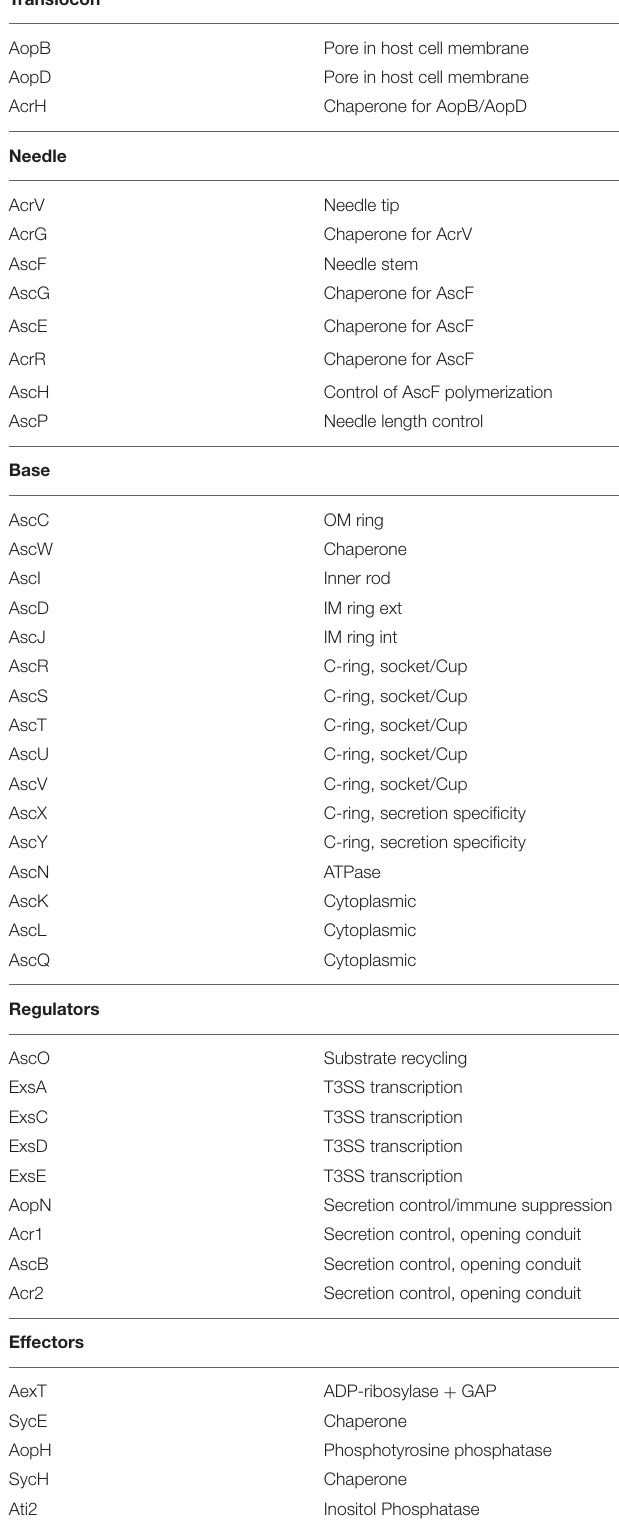
TABLE 1 | T3SS Proteins and pseudogenes and their